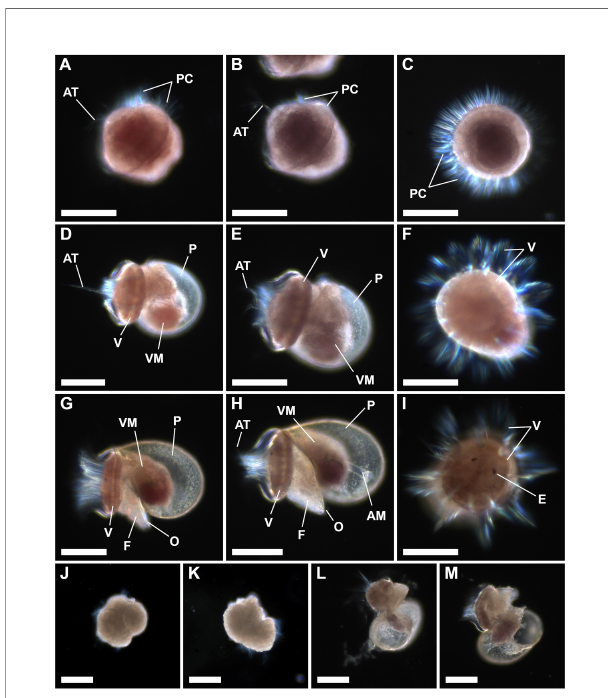
FIGURE 9 | Larval development of the limpet species P . aspera and P . candei . Trochophore stage ca. 17 – 24 h post-fertilization (A – C) : P . aspera